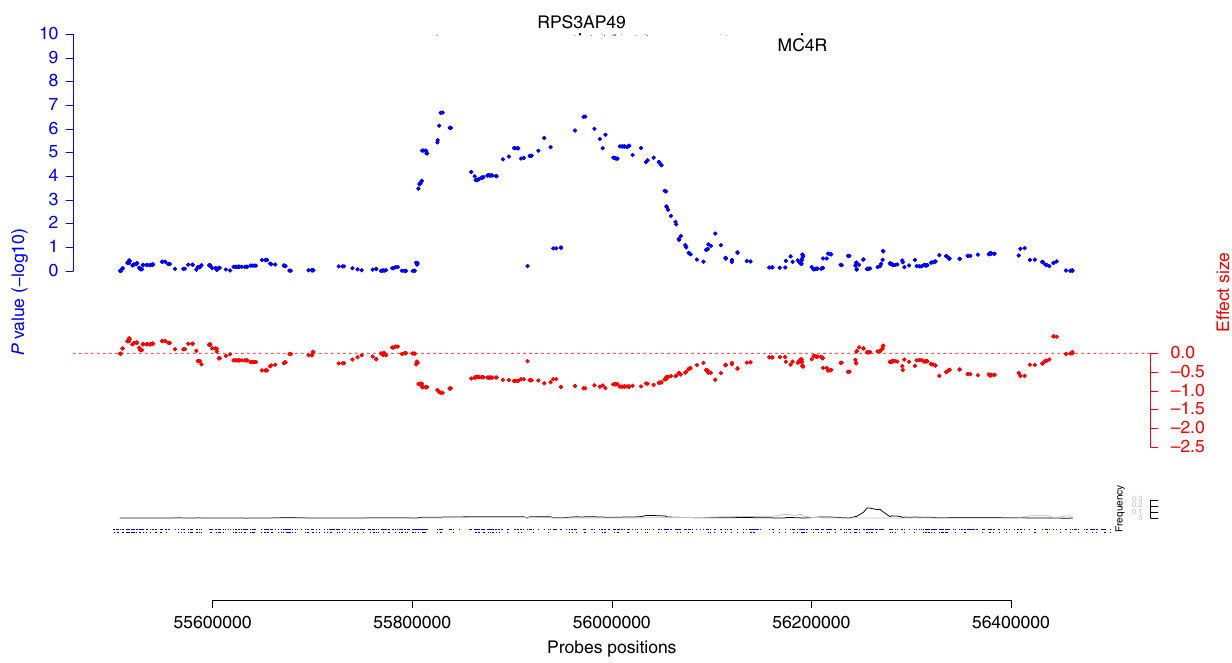
Fig. 3 Regional association plot for the rearrangement near MC4R . The blue dots represent – log10 BMI-association P values, the red dots show the corresponding effect sizes. At the bottom the black and gray lines are the deletions and duplications frequencies. Finally, the dots at the bottom are the probes positions for the GIANT cohorts above and the UK BioBank below . Positions of the protein-coding genes are shown at the top of the plot along with the position of the BMI-associated GWAS SNP. The probes positions correspond to the human genome build